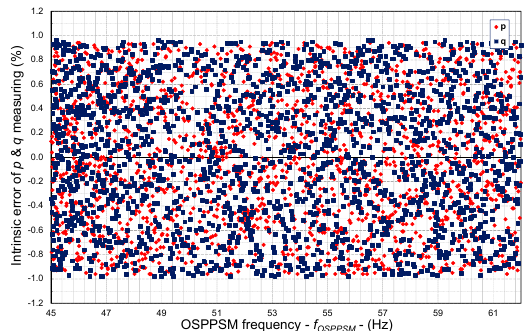
Figure 20. Wattmeter and varmeter test: Intrinsic error of different variable measuring.